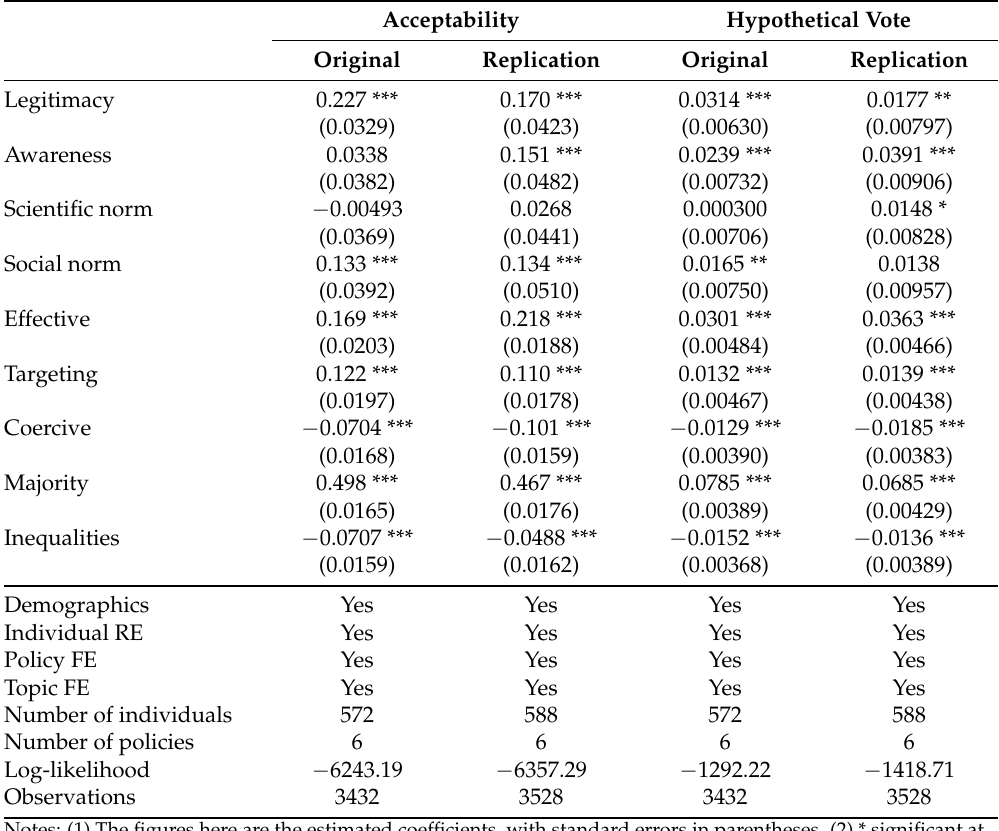
Table 8. Results of the replication study: original and replicated estimates of the regressions of policy acceptability scores and hypothetical